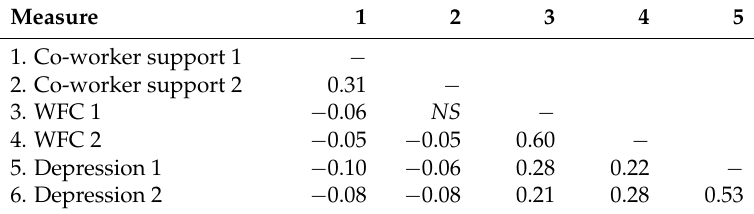
Table 2. Correlation matrix of study variables for Australian